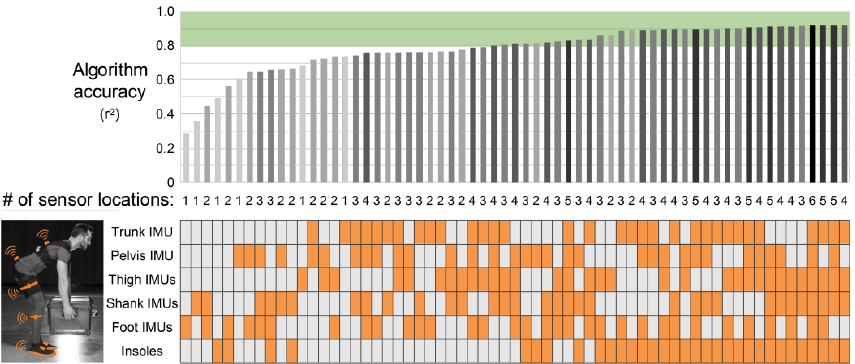
Figure A1. Number of sensor locations and specific sensor combination influences algorithm